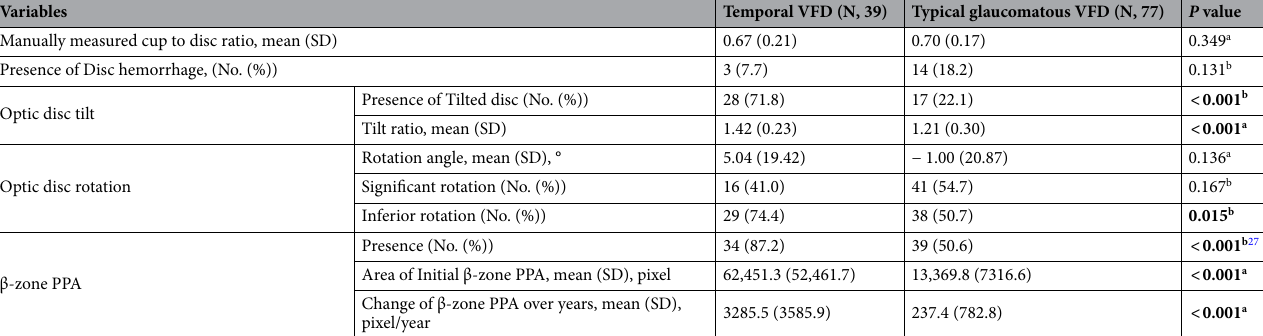
Table 3. Comparison of optic disc and posterior pole profiles. VFD visual field defect, PPA peripapillary atrophy. a Student’s t-test after Propensity score match, b chi-squared test. Bold font indicates significant P values ( P <